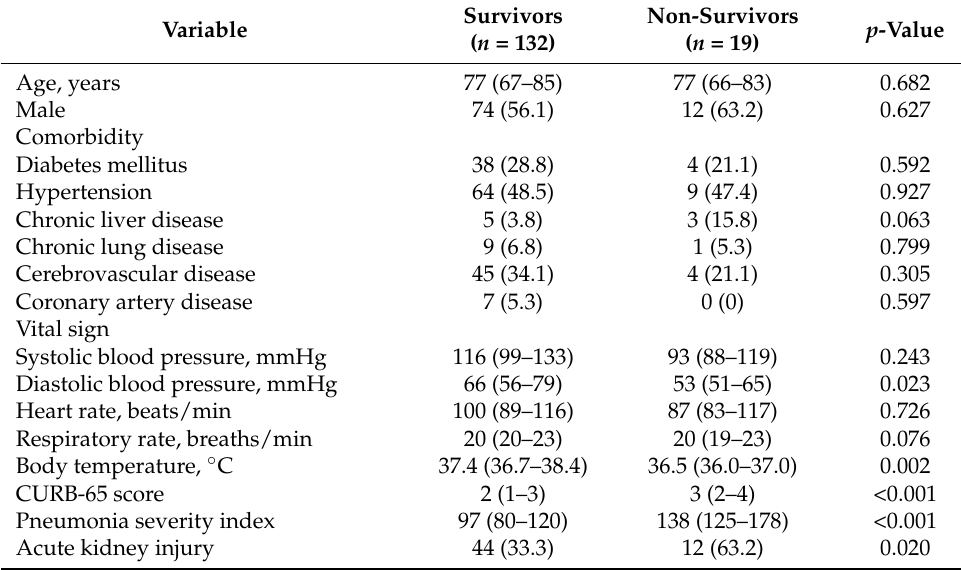
Table 5. Comparison of demographic and clinical characteristics between survivors and non- survivors among patients with COVID-19.